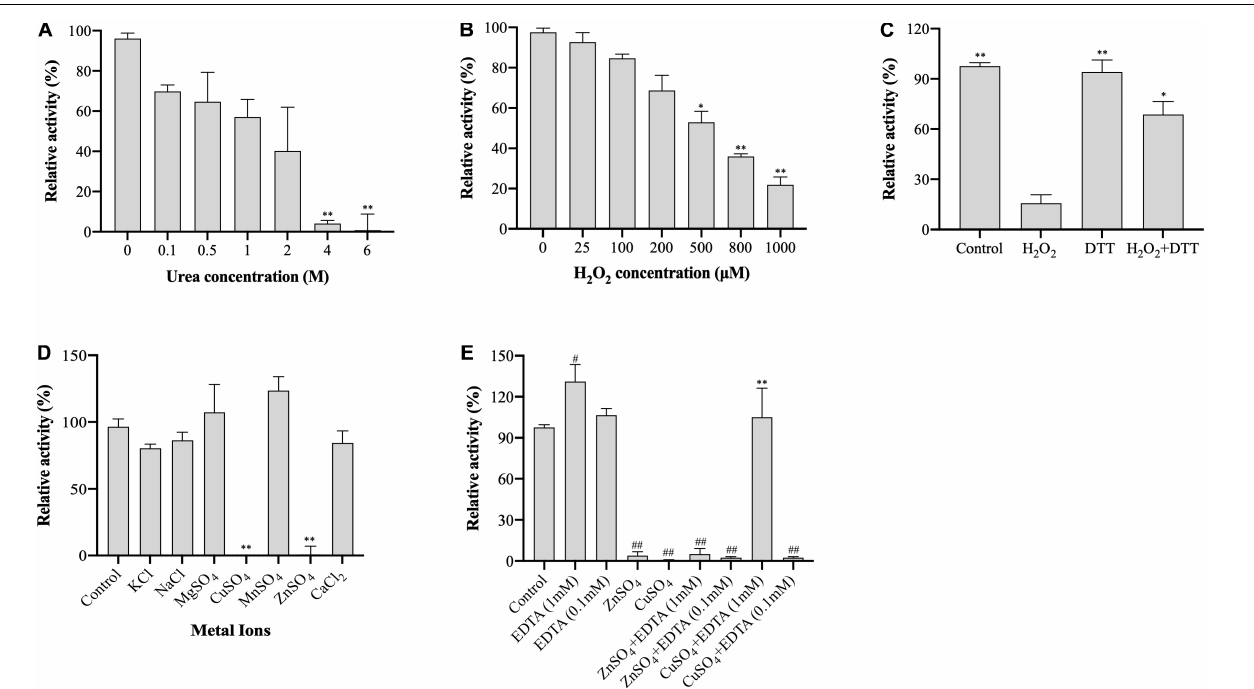
FIGURE 4 | Effect of urea, H 2 O 2 , and metal ions on the activity of (VIBVN)NAT. The activity of NAT was detected by the DTNB method. (A) Urea at various concentrations was mixed with 25 µ g/mL (final concentration) of the enzyme, 500 µ M AcCoA and 500 µ M acetyl acceptors in 25 mM Tris–HCl buffer (pH 7.5) at room temperature. The enzyme activity obtained without urea was defined as 100%. The data are presented as the mean ± SD of three independent experiments. Error bars indicate SD values. The results are presented as percent control (urea 0 µ M) of the activity of NAT. ** p < 0.01 when compared to the control group. (B) H 2 O 2 at various concentrations was mixed with 25 µ g/mL (final concentration) of the enzyme, 500 µ M AcCoA and 500 µ M acetyl acceptor 25 mM Tris–HCl buffer (pH 7.5) at room temperature. The enzyme activity obtained without H 2 O 2 was defined as 100%. The data are presented as the mean ± SD of three independent experiments. Error bars indicate SD values. The results are presented as percent control (H 2 O 2 0 µ M) of the activity of NAT. * p < 0.05, ** p < 0.01 when compared to the control group. (C) H 2 O 2 at 1 mM (final concentration) was mixed with 25 µ g/mL (final concentration) of the enzyme. The oxidized enzyme was then incubated with 1 mM DTT for 10 min. The enzyme activity obtained without H 2 O 2 and DTT was defined as 100%. The data are presented as the mean ± SD of three independent experiments. Error bars indicate SD values. The results are presented as percent control (H 2 O 2 0 µ M, DTT 0 µ M) of the activity of NAT. * p < 0.05, ** p < 0.01 when compared to the H 2 O 2 -inactivated (VIBVN)NAT. (D) Different kinds of metal ions were mixed with 25 µ g/mL (final concentration) of the enzyme, 500 µ M AcCoA and 500 µ M acetyl acceptor 25 mM Tris–HCl buffer (pH 7.5) at room temperature. The enzyme activity obtained without metal ions was defined as 100%. The data are presented as the mean ± SD of three independent experiments. Error bars indicate SD values. The results are presented as percent control (no metal ion) of the activity of NAT. ** p < 0.01 when compared to the control group. (E) ZnSO 4 and CuSO 4 were mixed with 25 µ g/mL (final concentration) of the enzyme, and then the enzyme was incubated with EDTA at 0.1 or 1 mM for 10 min. The enzyme activity obtained without metal ions and EDTA was defined as 100%. The data are presented as the mean ± SD of three independent experiments. Error bars indicate SD values. The results are presented as percent control (no metal ion, EDTA = 0 µ M) of the activity of NAT. ** p < 0.01 when compared to the CuSO 4 -inactivated (VIBVN)NAT. ## p < 0.01, # p < 0.05 when compared to the control